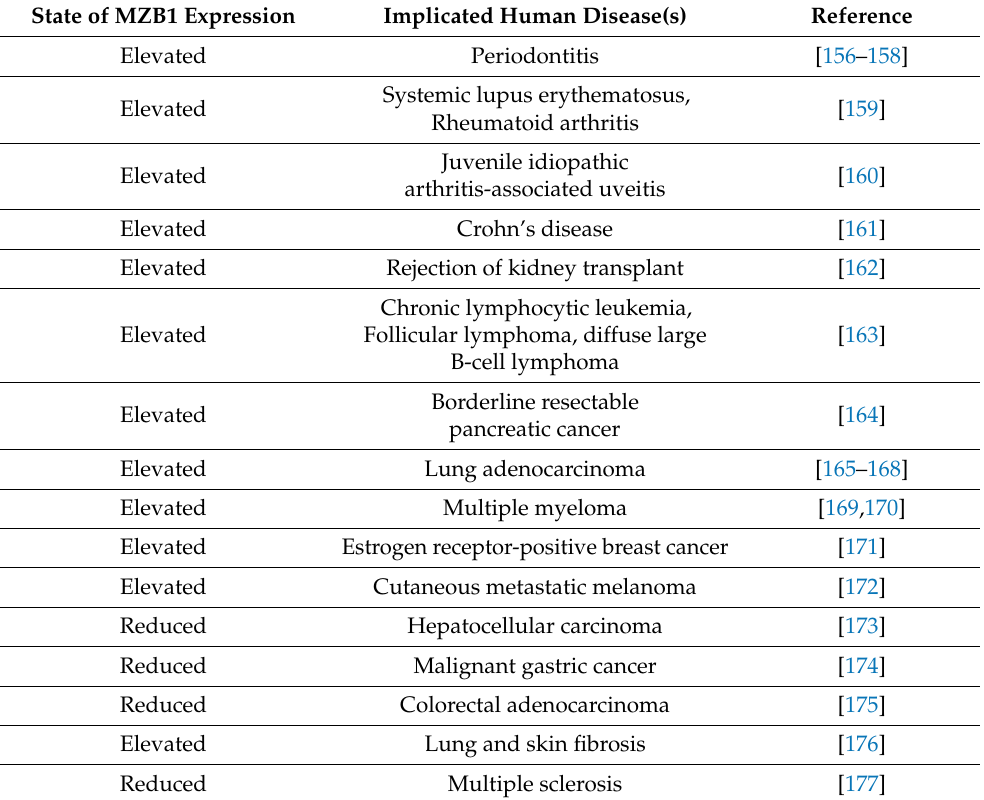
Table 1. Implications of marginal zone B and B-1 cell specific protein (MZB1) in human